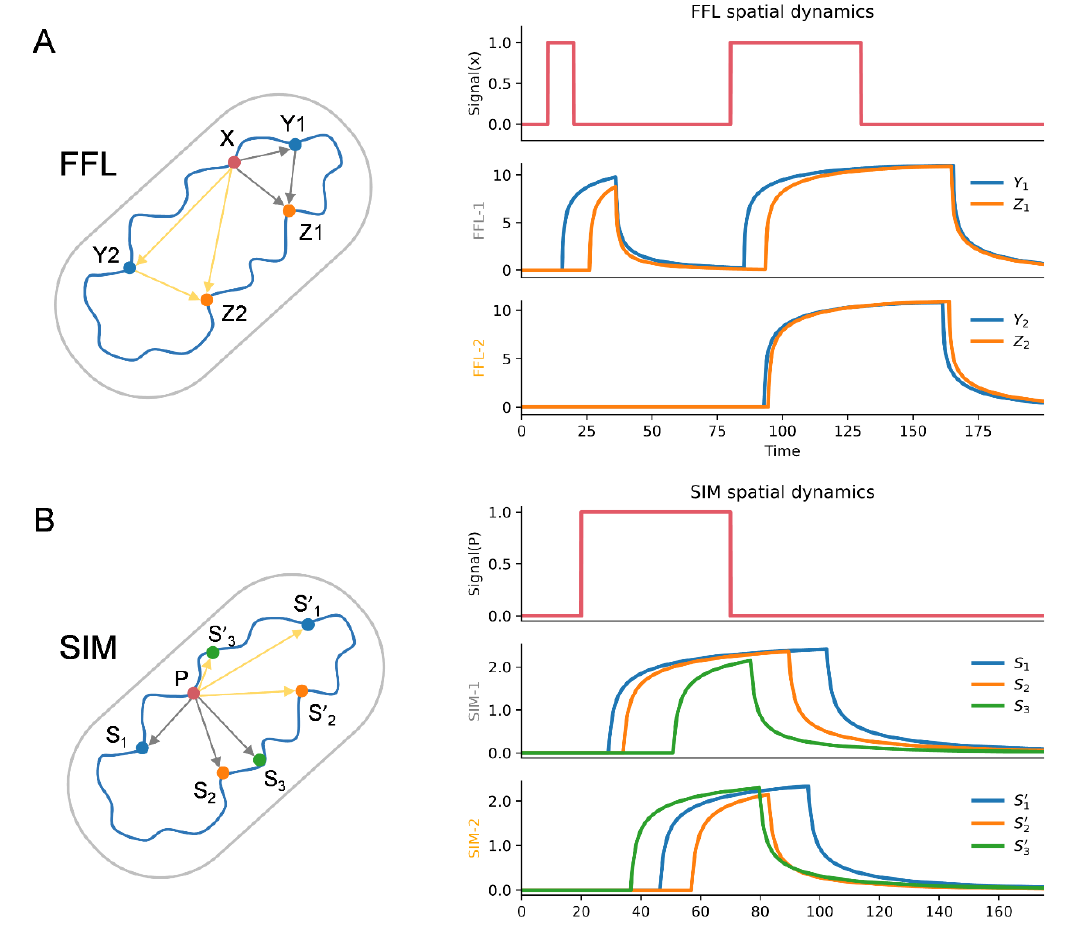
Figure 7. Dynamic behaviors affected by the spatial organization of FFL and SIM. ( A ). For FFL-1 (grey edges), suppose D X_Y1 = D X_Z1 = 2√ 2, D Y1_Z1 = 4; for FFL-2 (yellow edges), suppose D X_Y2 = 2√5 , D X_Z2 = 3√ 2, D Y2_Z2 = √ 2 (see Table S5 for the coordinates of X, Y1, Z1, Y2, Y2). FFL-1 responds to both signals, while FFL-2 just responds to the longer one, which means different spatial distributions of genes in FFL can affect dynamic function. ( B ). In SIM-1 (grey edges), the distances between the three child nodes (S 1 , S 2 , S 3 ) and the parent node P are assumed to be identical, and the three child nodes can be regulated in a correct time order. In SIM-2 (yellow edges), the distances between the child nodes and the parent node are randomly arranged, and the original time order disappears. This result indicates that the spatial distribution of genes in SIM can affect dynamic function. Time could have arbitrary unit because it is just for conceptual illustration.